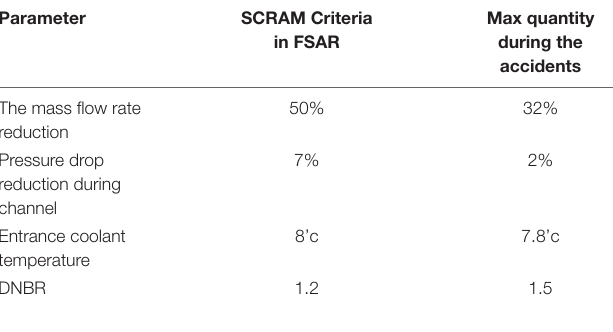
TABLE 7 | Comparison of SCRAM limits and maximum quantities at ATWS